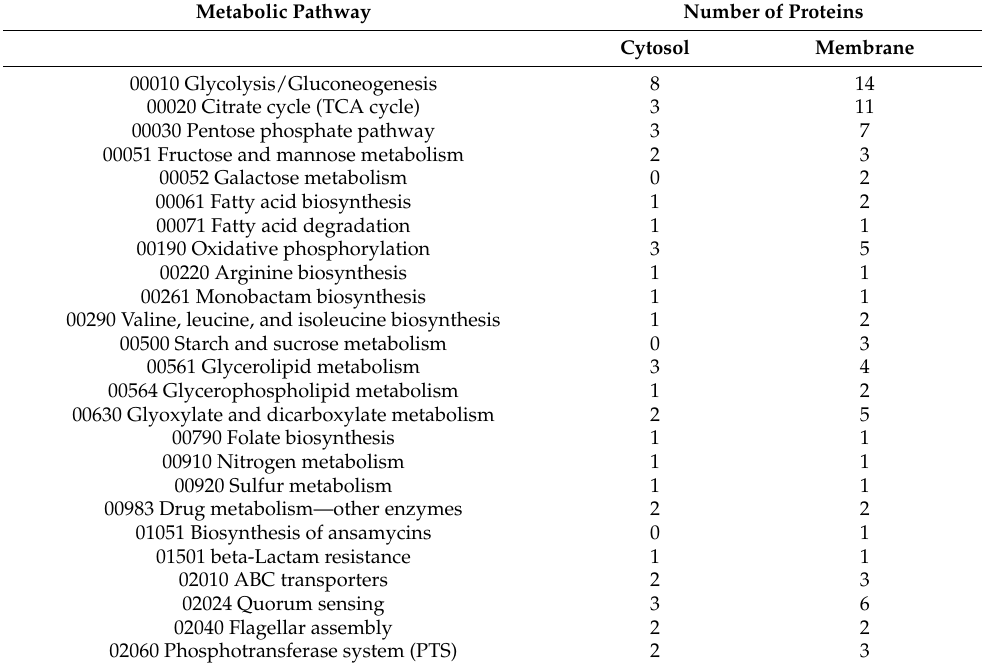
Table 1. Ontology of proteins expressed by Bacillus pumilus UAMX